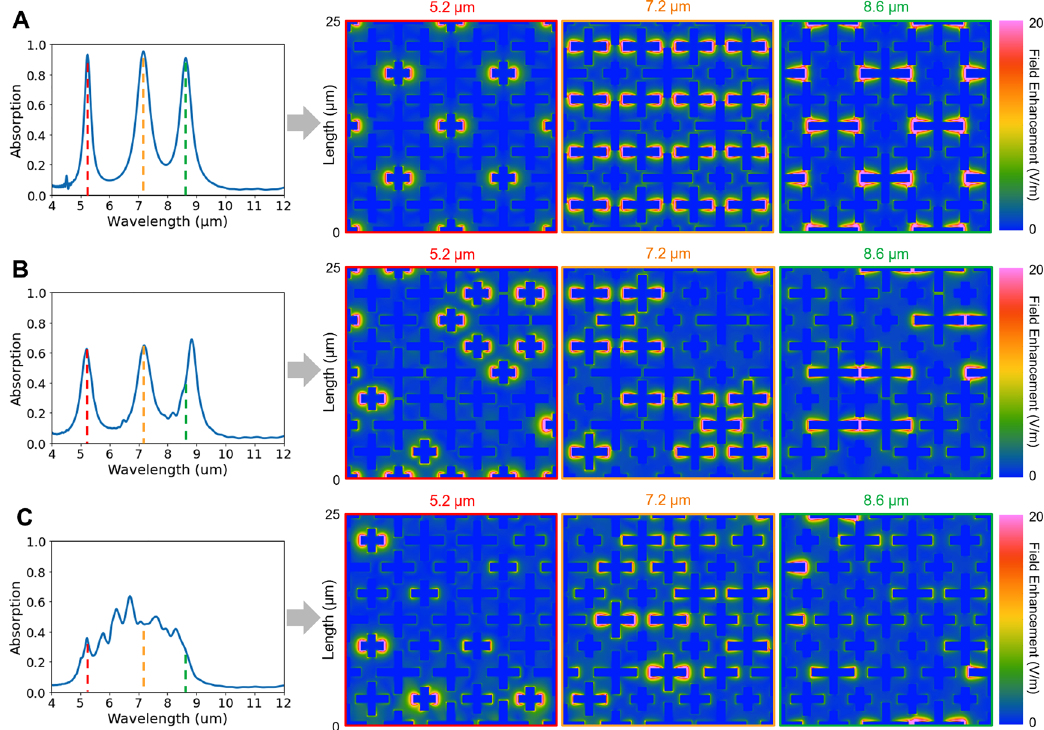
Figure 4: Relationships between supercell absorption properties and their subunit resonator spatial distributions. Simulated absorption spectra (of the tandem network-designed structures) and corresponding electric field profiles are shown for triple-narrowband structures with (A) high and (B) low absorption peaks and a (C) graybody structure. These plots reveal the dependence of absorption response on resonator geometry and position relative to other